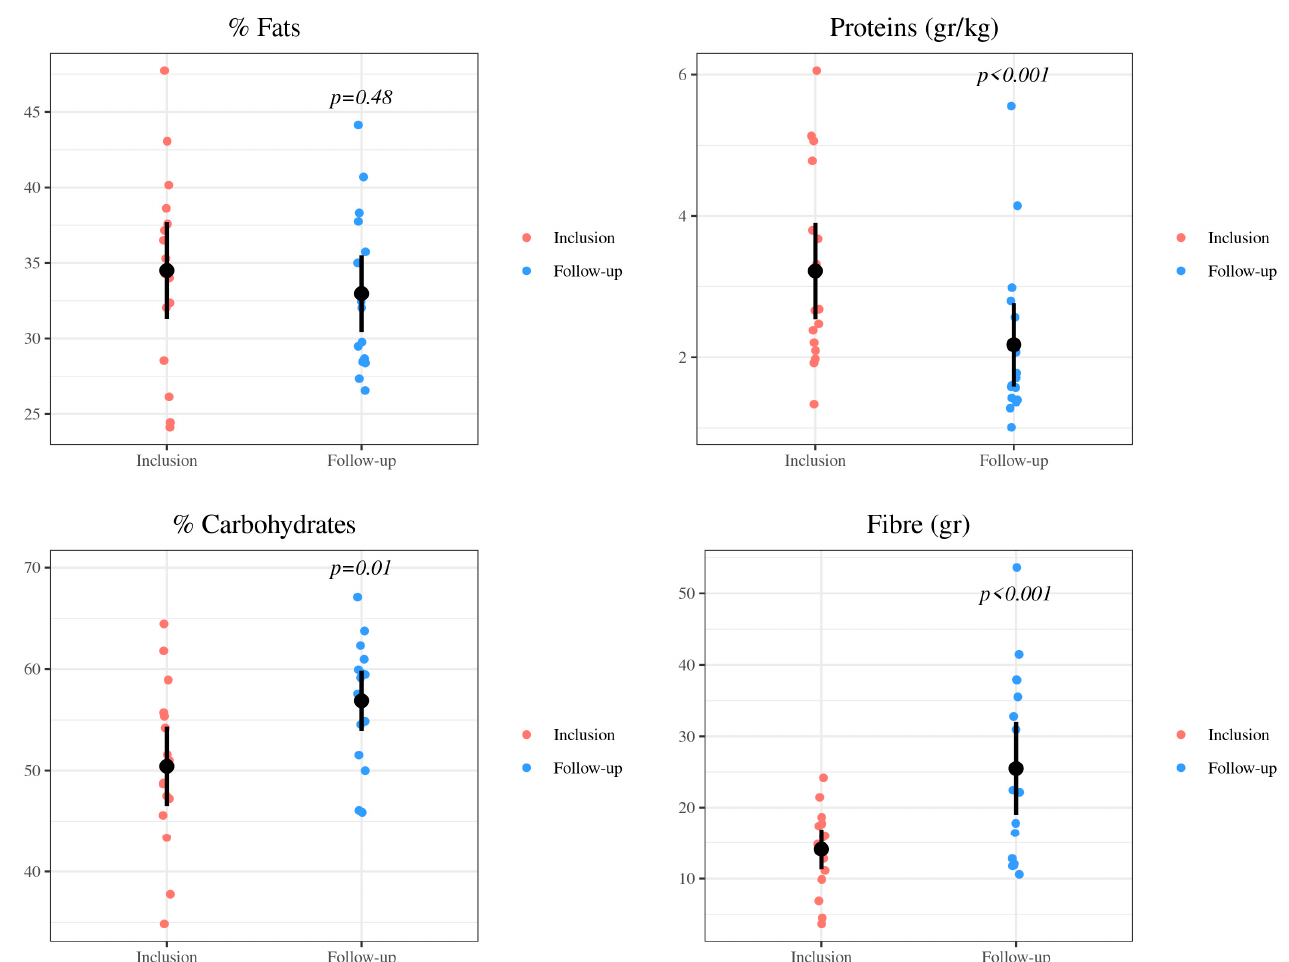
Figure 1. Ingestion of macronutrients at baseline and last follow-up after the nutrition intervention. Fats (% fats), carbs (% carbohydrates) and grams of protein per kilogram of body weight (protein/kg), as well as grams of fiber each day (fiber), consumed by 16 pediatric subjects with CKD. Table 3. Daily energy and nutrients consumption at baseline and last follow-up after nutrition in- tervention.